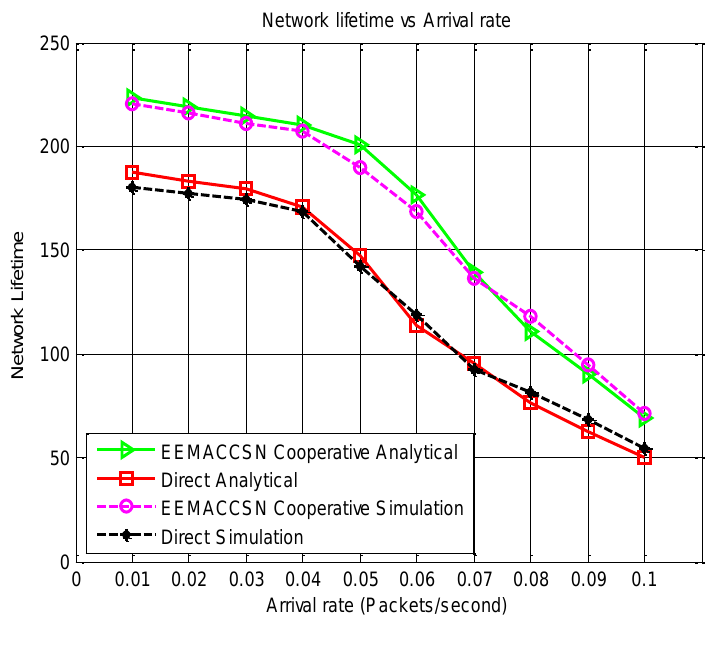
Figure 11. Network lifetime vs. arrival rate.